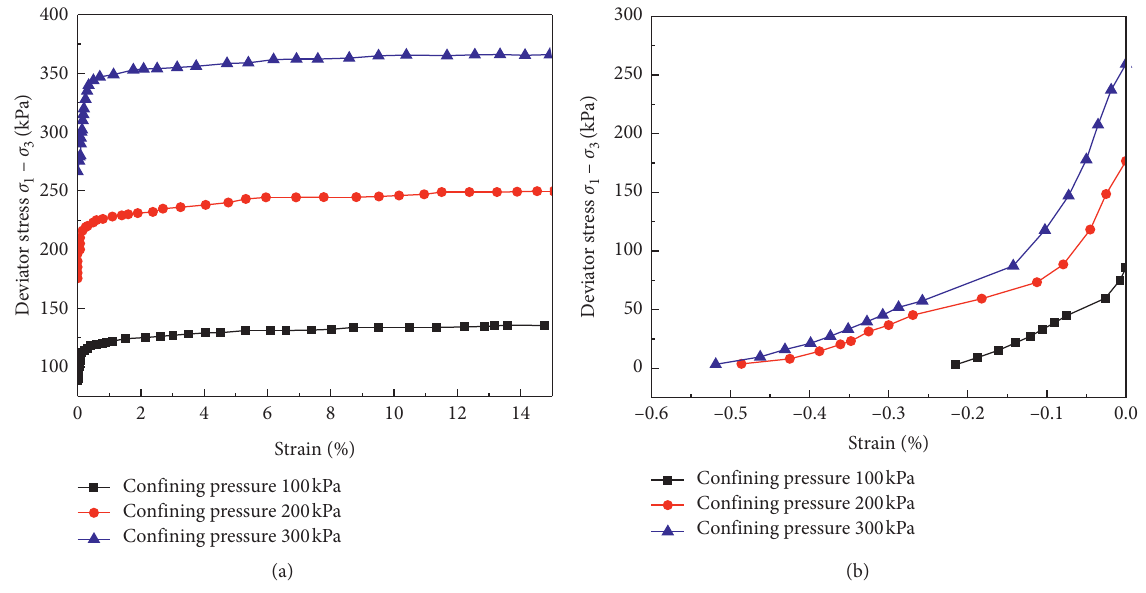
Figure 5: Deviator stress and axial strain under different consolidation confining pressures. (a) Stress path UU0.5. (b) Stress path